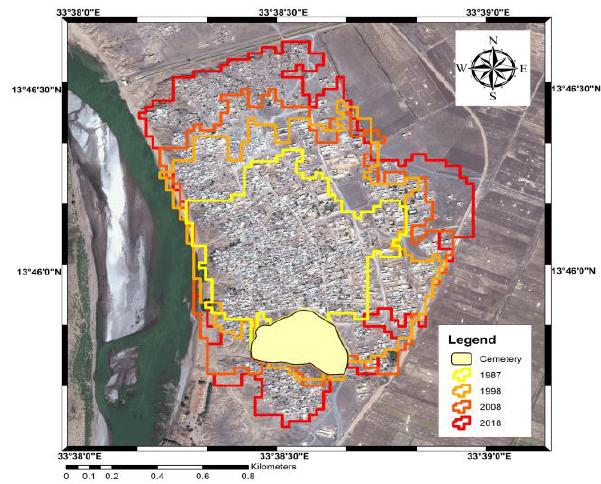
Figure 2. Expansion of built-up areas between 1987 and